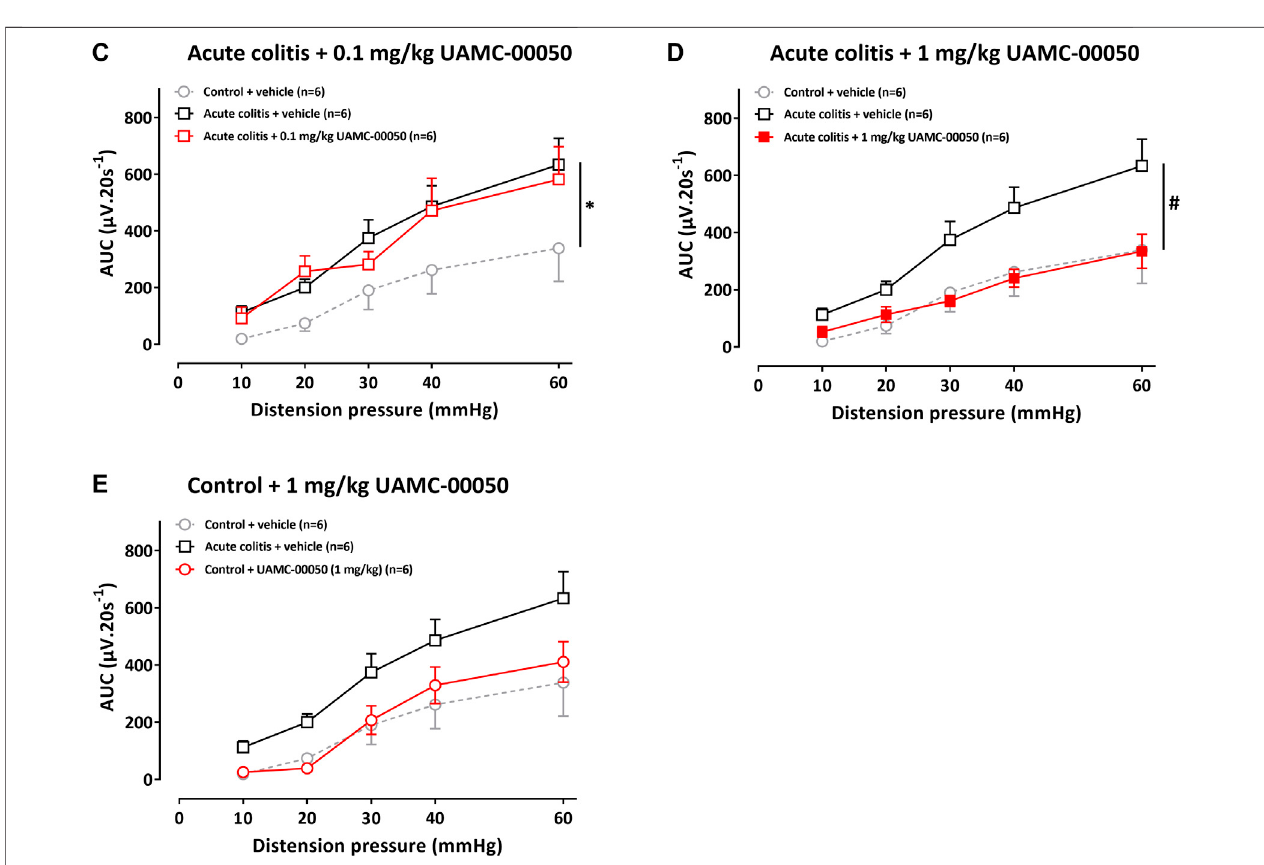
FIGURE 1 | TNBS; 2,4,6-trinitrobenzenesulfonic acid; VMR; visceromotor response. (B) Example of a processed EMG tracing (DC remove (time constant 0.1 s), full- waverecti fi cationandsmoothening(timeconstant0.01 s);µV),presentedforeachdistensionpressure(mmHg). (C – E) TheeffectofUAMC-00050(0.1 – 1 mg/kg)andits vehicle (5% DMSO) on VMRs in acute colitis (squares) and control (bullets) rats. The statistical analysis was performed on the complete dataset, but separate graphs were made for each dose for the purpose of clari fi cation. Data are presented as mean ± SEM. Generalized Estimating Equations (GEE) + Bonferroni-Holm correction